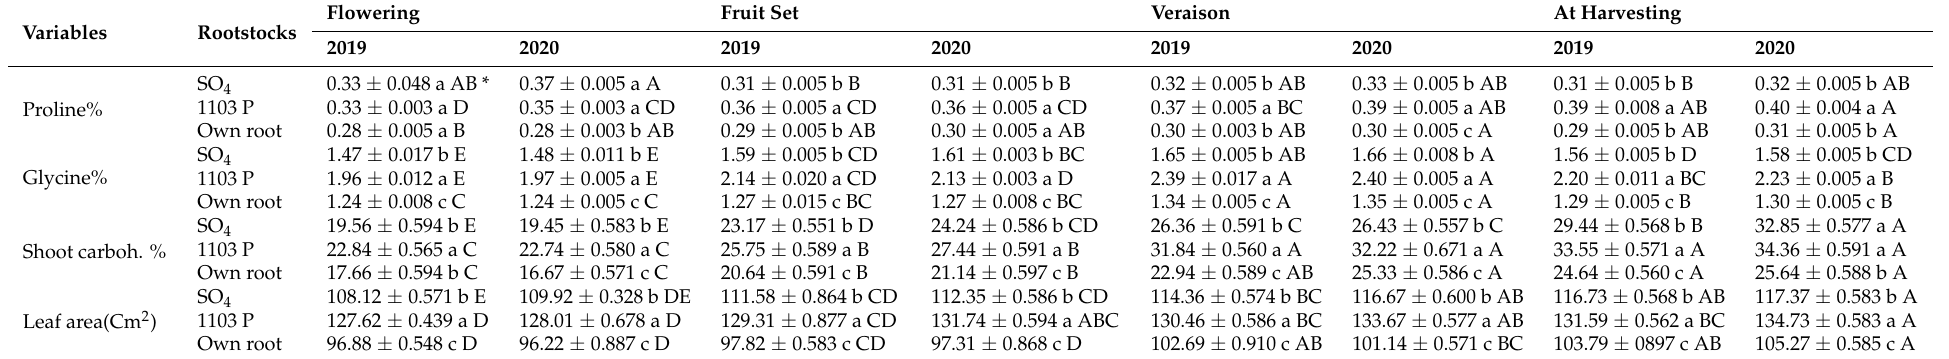
Table 3. The effect of rootstocks (SO 4 , 1103 Paulson, and own root) on proline, glycine, shoot carbohydrate percentage, and leaf area (cm 2 ) were assessed four times during two growth seasons (2018–2019) on various berry developmental phases (flowering, fruit set, veraison, and at harvest time) of “superior seedless”